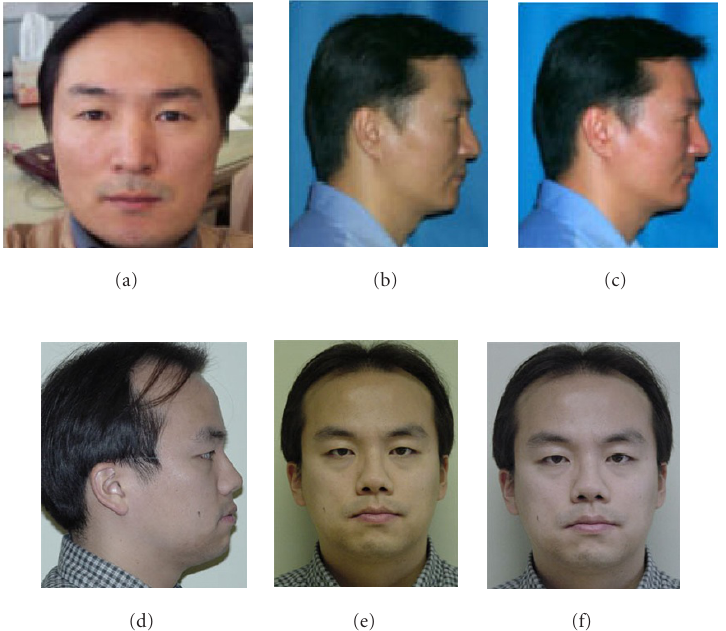
Figure 17: The results of color adjustment. (a) and (d) Reference image. (b) and (e) Input source image before adjustment. (c) and (f) Output image after